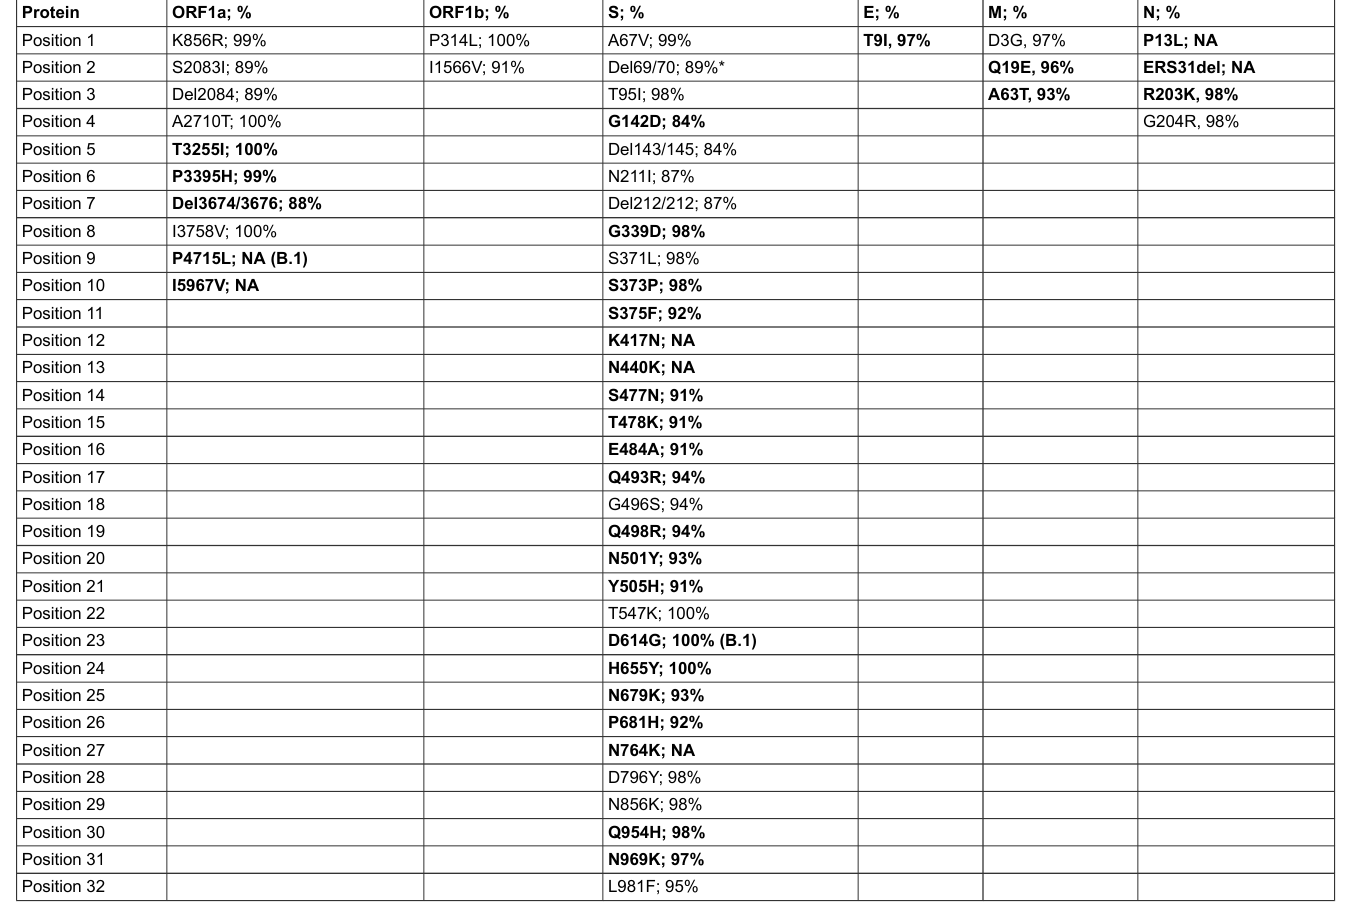
Table 1: Summary of the commonly found mutations in Omicron and % of presence (based on 127 sequences; outbreak.info). New sublineages BA.1 and BA.2 are available at https://github.com/cov-lineages/pango-designation/issues/361.